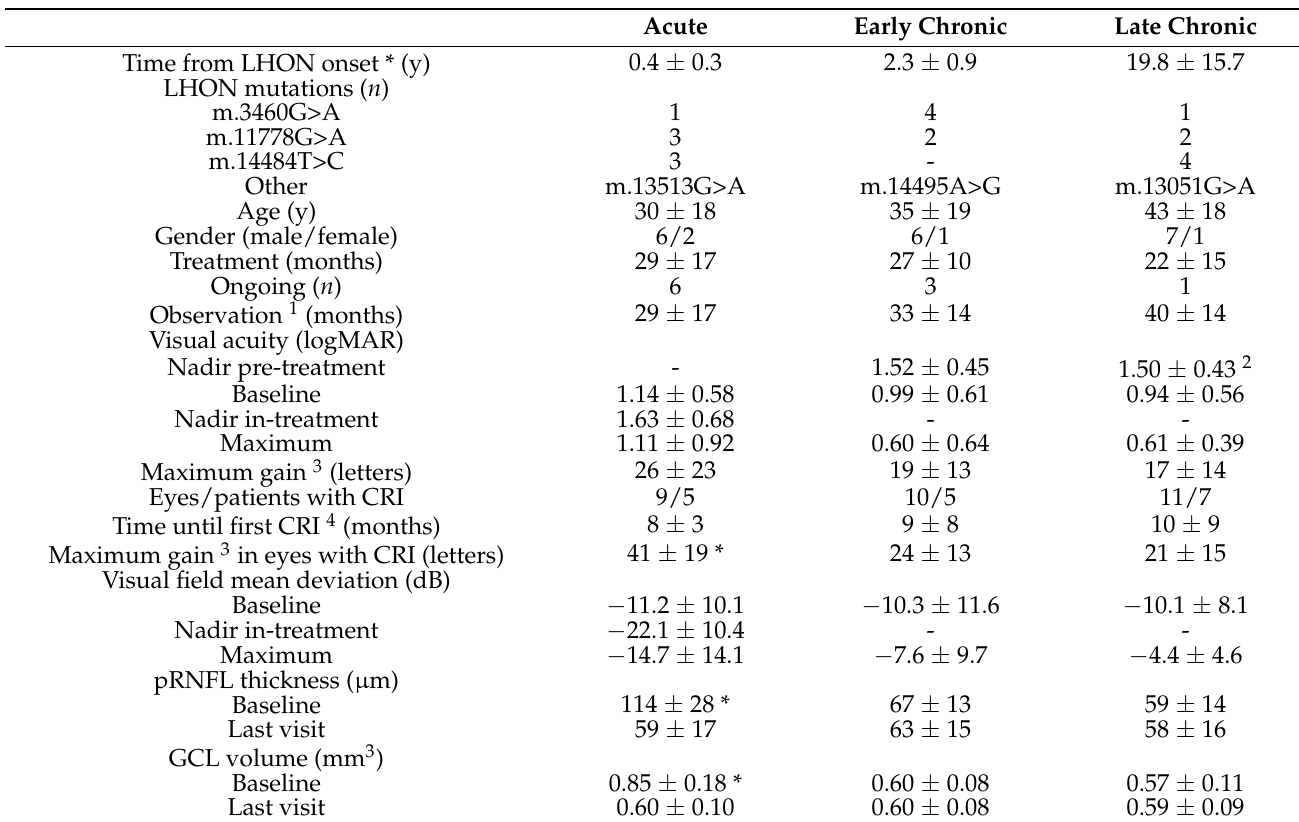
Table 1. Patient characteristics of acute and chronic LHON